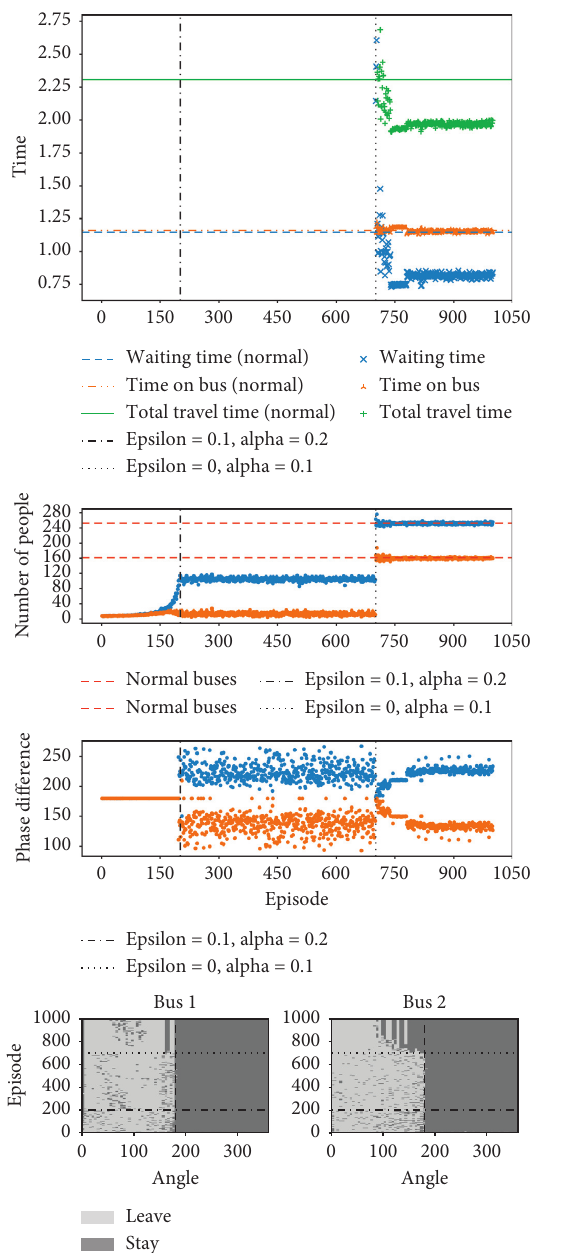
Figure 4: Two buses with frequency detuning serving a loop of bus stops during a busy period learn the no-boarding strategy by re- inforcement learning. The results are qualitatively similar to those in Figure 3.